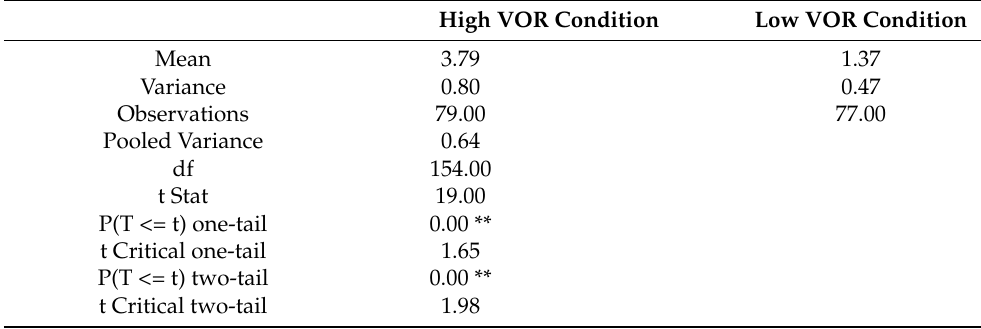
Table 9. Study 2b Manipulation Check.